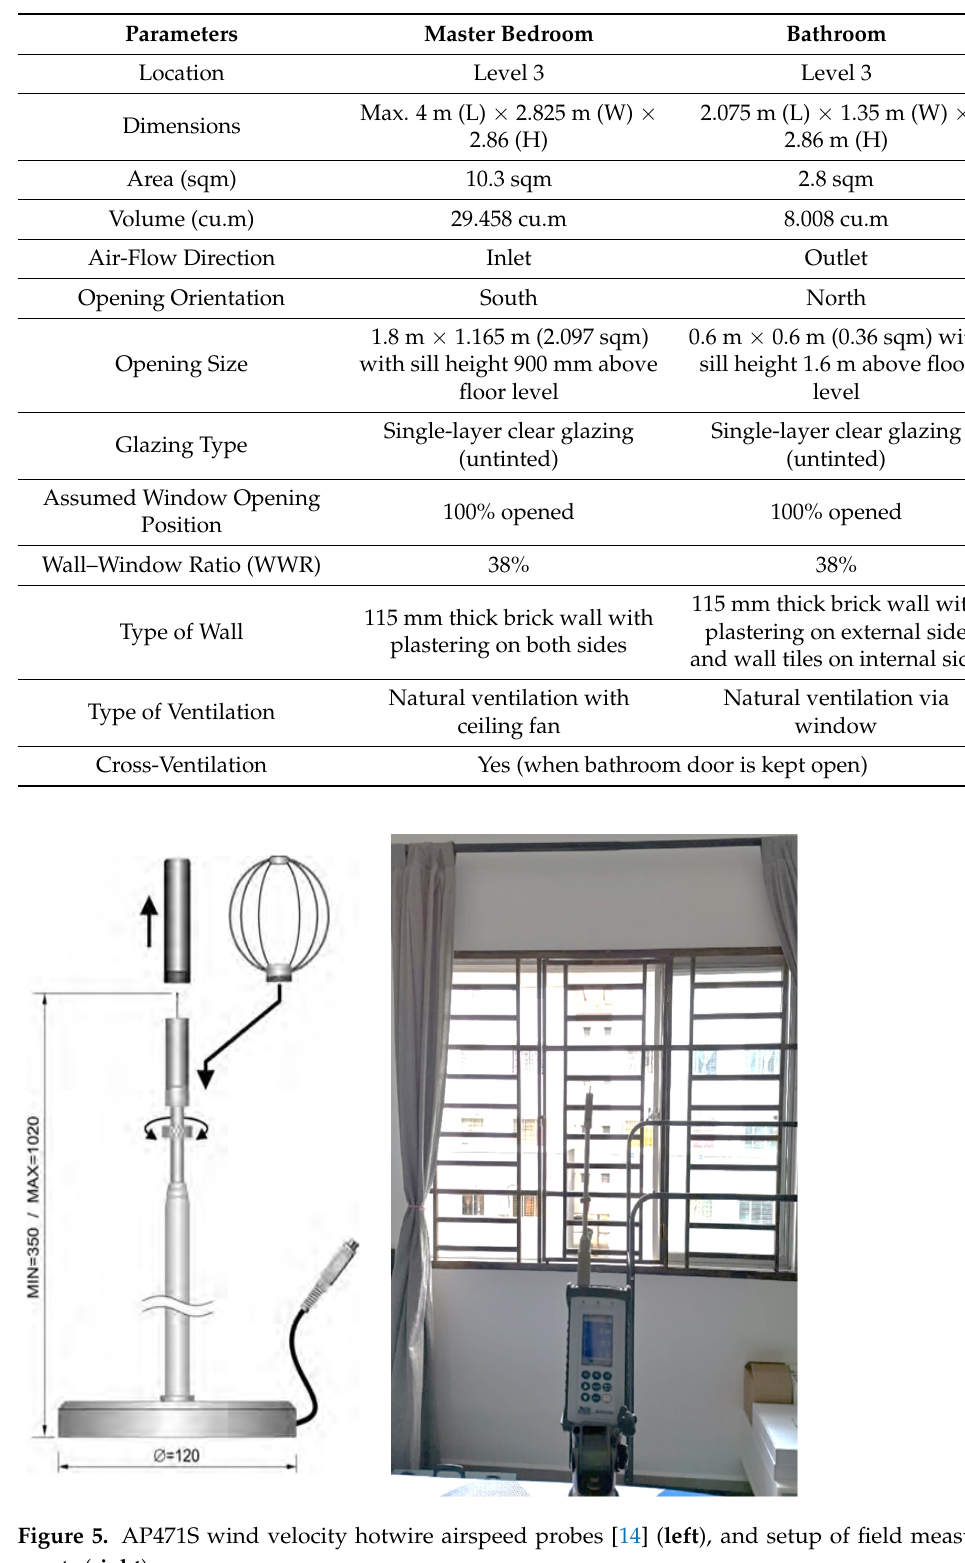
Figure 6. Position of the wind velocity sensor in the case study room (master bedroom in a Level 3 apartment unit). The results of the field measurements are shown in Figure 7. The results from the initial set-up day on 25 March 2022 were disregarded, as the recordings only commenced in the evening. The average wind velocity measured in the case study unit was 0.019 m/s, with a range of 0–1.1 m/s. Based on the recorded data, 69.56% of the total field measure- ments recorded 0 m/s. The wind velocity exceeded 1 m/s only thrice—at 14:44 and 14:29 on 27 March 2022, and also at 14:34 on 28 March 2022—due to increased wind flow during rainy periods. This represented 0.13% of the measured duration. Out of the 2314 recorded data values logged during the 8 days, there were only 39 instances detected of wind velocity exceeding 0.2 m/s, and 17 instances of wind velocity exceeding 0.4 m/s. Therefore, it can be inferred that the indoor airflow was poor, and the